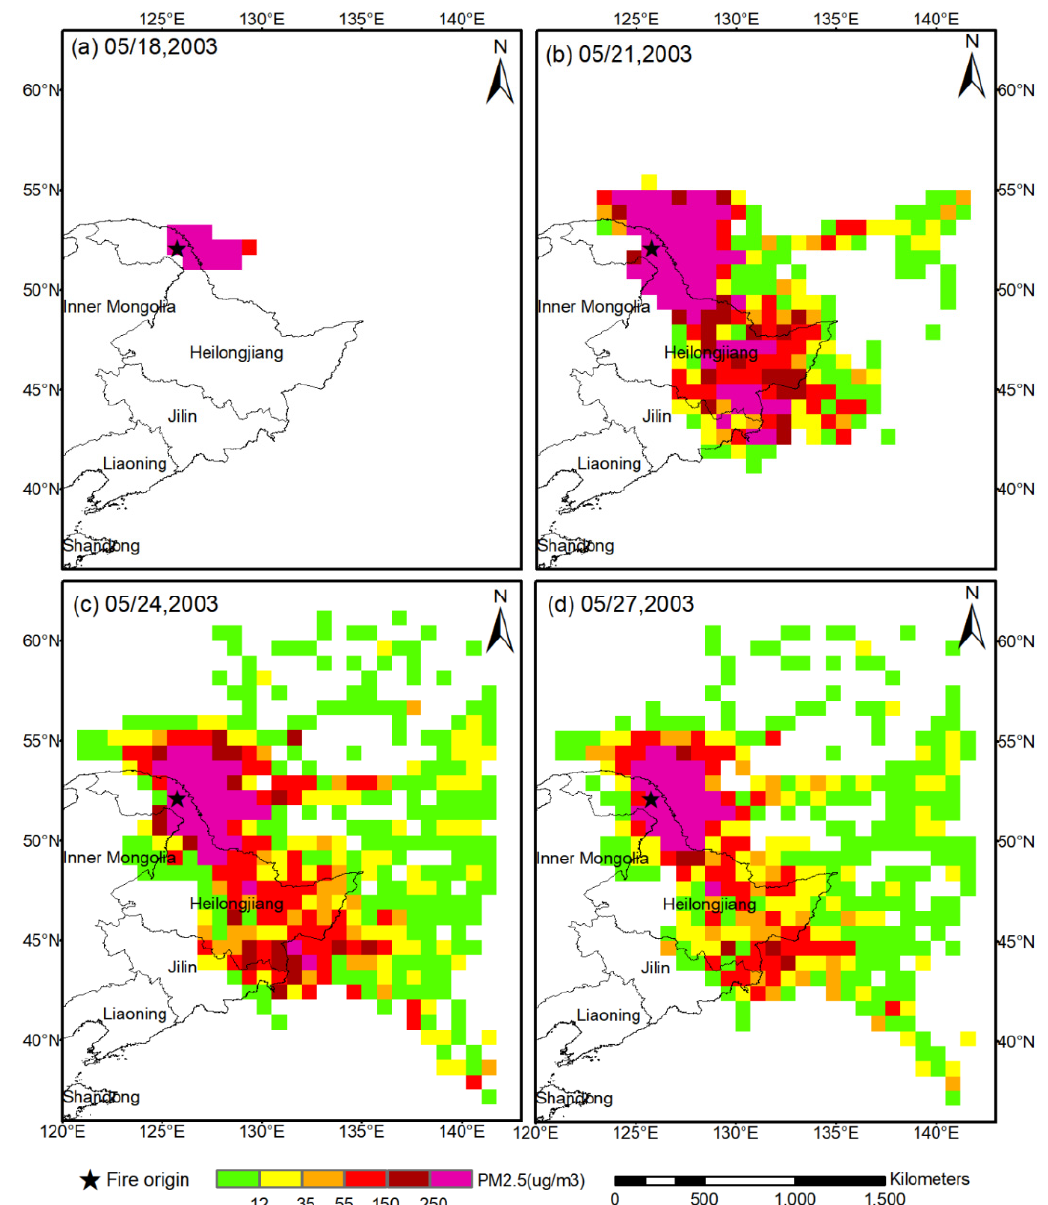
Figure 3. Simulated smoke plume from the Shibazhan fire. Each square box is a model grid point (approximately 25 km × 25 km). The names in black are provinces. The green, yellow, orange, red, brown, and purple colors represent good, moderate, unhealthy for sensitive groups, unhealthy, very unhealthy, and hazardous air quality levels, respectively. Panels ( a – d ) are 18, 21, 24, and 27 May 2003, respectively.